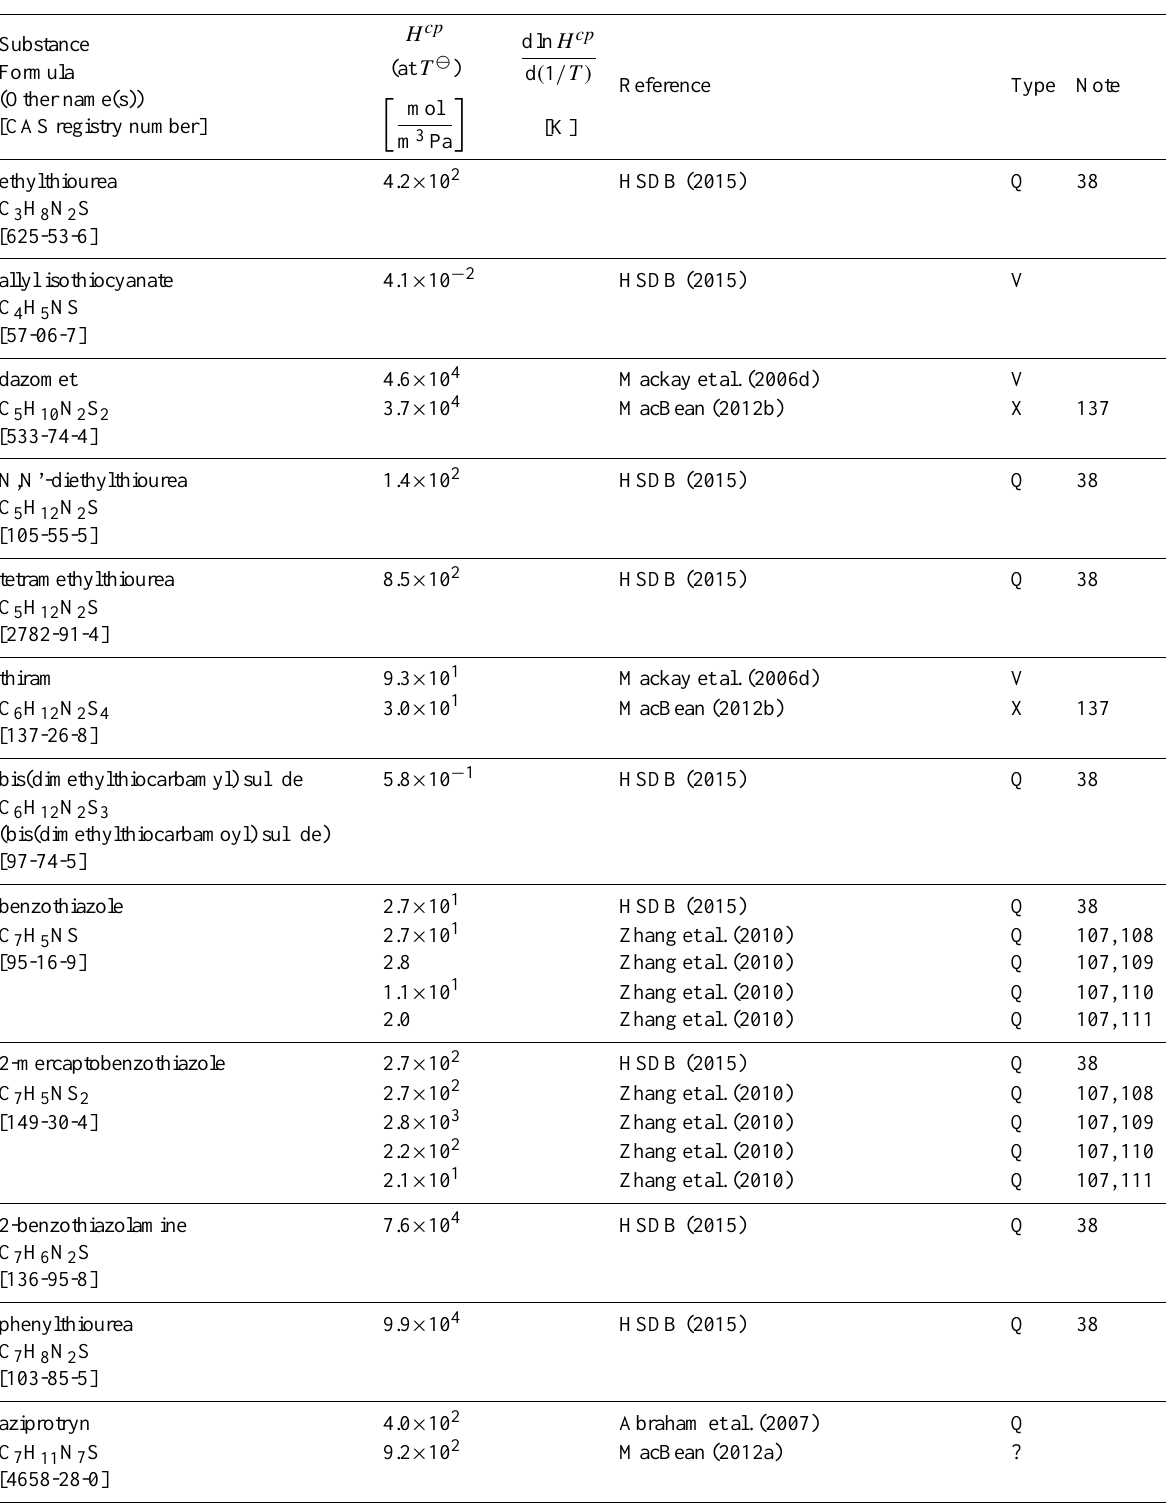
Table 6: Henry’s law constants for water as solvent